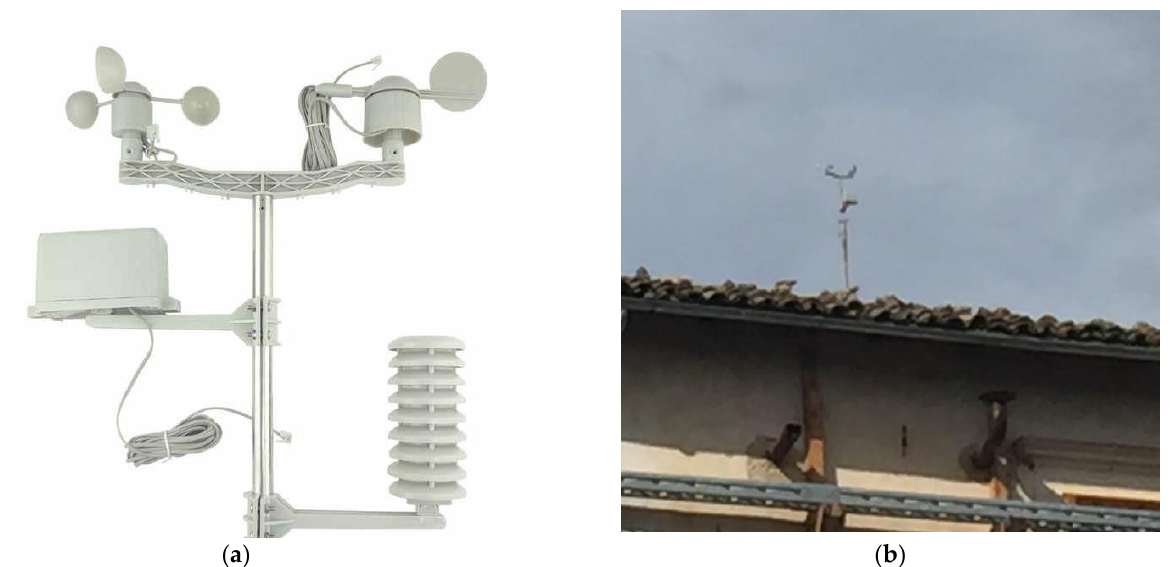
Figure 7. In the red circle the weather station installed on the roof: ( a ) weather station ( b ) weather station on the roof of the Palace.